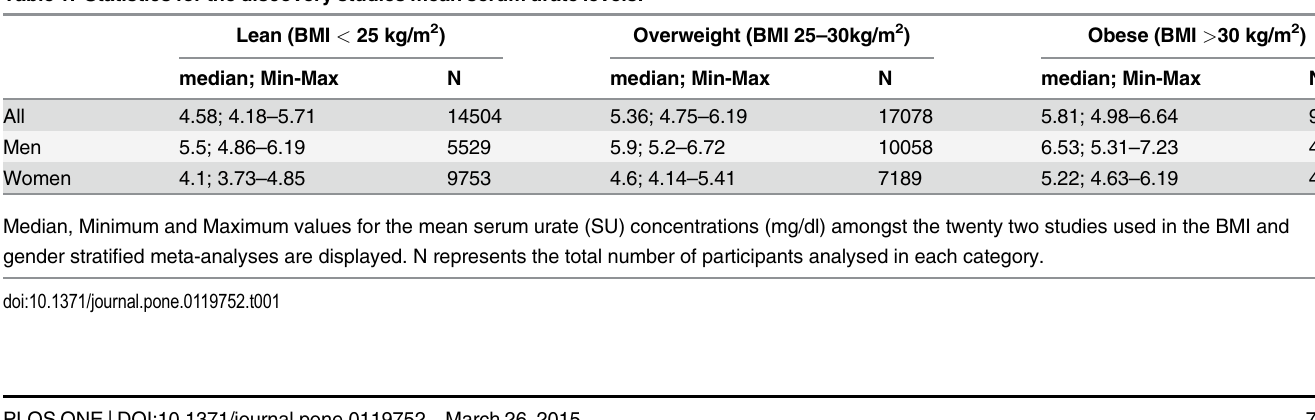
Table 1. Statistics for the discovery studies mean serum urate levels. Lean (BMI < 25 kg/m 2 ) Obese (BMI > 30 kg/m 2 )